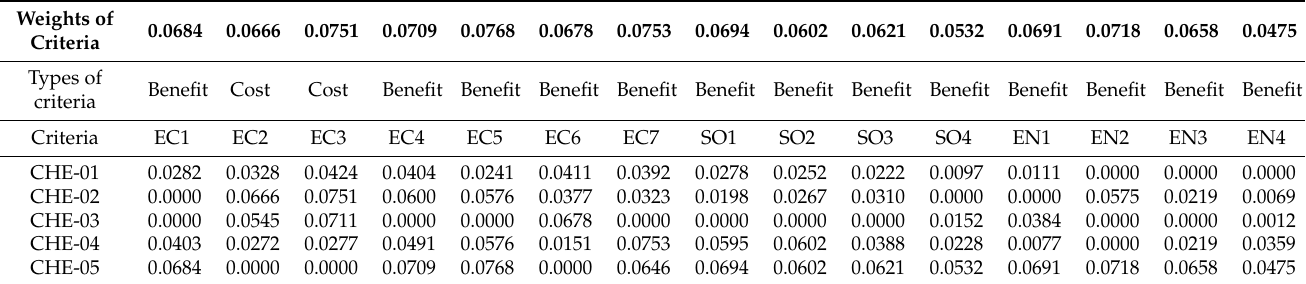
Table A2. The weighted comparability sequence matrix of the CoCoSo model.